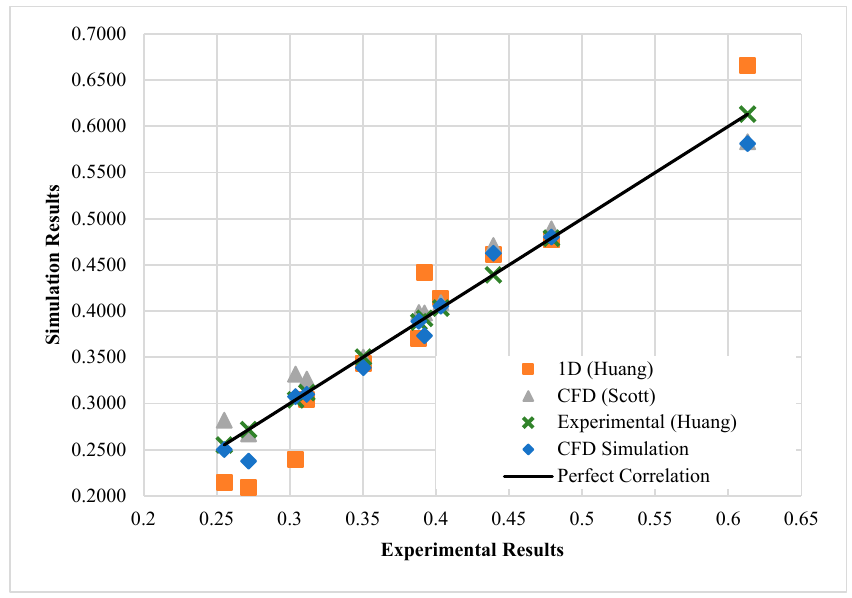
Figure 9. Validatio of CFD modeling with published data .